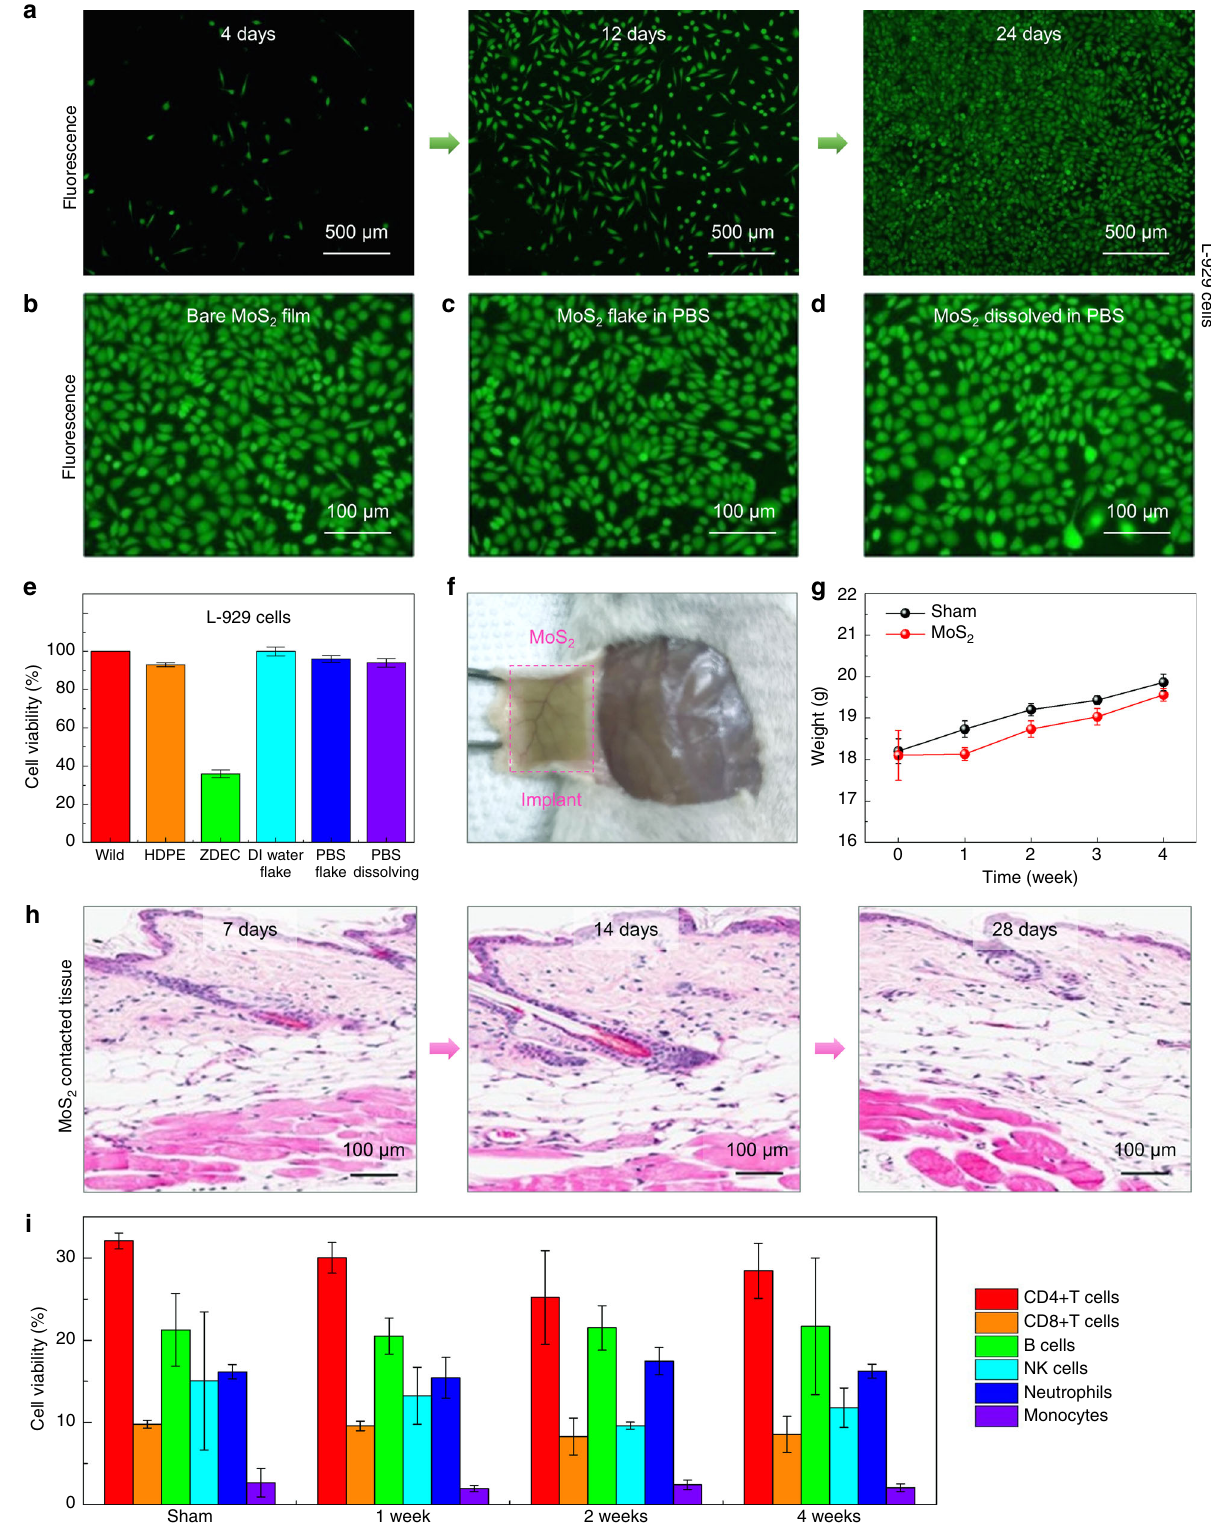
Fig. 4 In vitro and in vivo long-term biocompatibility tests of the polycrystalline MoS 2 monolayer. a Fluorescence images of cells on a MoS 2 monolayer following in vitro culture for 4, 12, and 24 days. b – d Fluorescence images of cells following 24 days of culture with different MoS 2 states, including MoS 2 continuous fi lm ( b ), PBS with MoS 2 fl akes ( c ), and dissolved MoS 2 ( d ). e Cell viability of L-929 cells, cultured for 24h in media containing HDPE or ZDEC, MoS 2 fl akes in DI water, MoS 2 fl akes in PBS, and MoS 2 dissolved in PBS, was assessed by the CCK-8 assay. f Images of MoS 2 fi lm implanted in the subdermal dorsal region of BALB/c mice for 4 weeks. g The body weight of mice after the subcutaneous implantation of devices for 4 weeks. h Immunohistochemistry of tissues surrounding the implanted MoS 2 . The individual tissue sections surrounding the implanted MoS 2 were subjected to H&E staining and photographed. i Immunopro fi ling of cell populations in peripheral blood after the implantation of MoS 2 in mice for 4 weeks. The individual immune subsets (CD4, CD8, B cell, NK cell, neutrophil, and monocytes) are presented as a percentage of immune cells found in the peripheral blood. Error bars of the experimental data represent standard error of